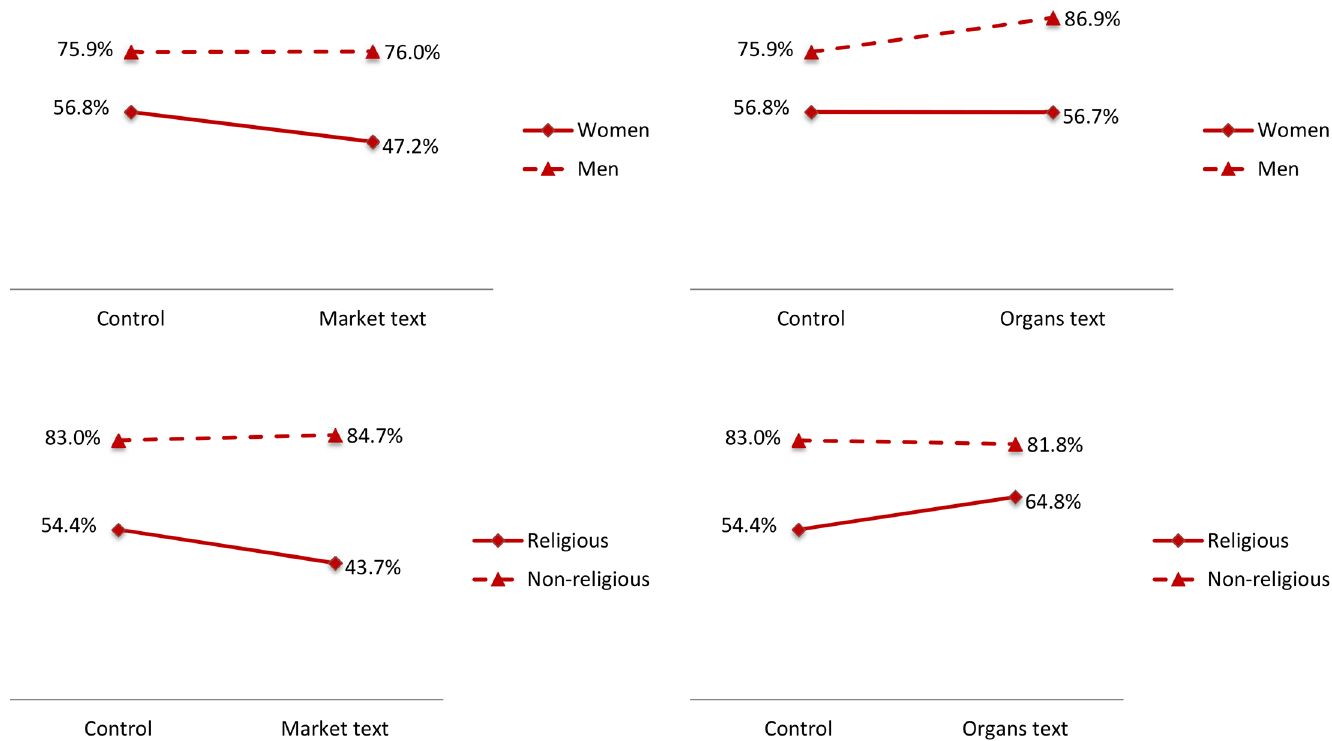
Fig 3. Estimated support for legalizing indoor prostitution, by gender and religiosity. Notes: The figures report the percentage of subjects favoring either payments for organs or legalizing indoor prostitution, by treatment condition and demographic trait. See notes to Fig 2 for details.